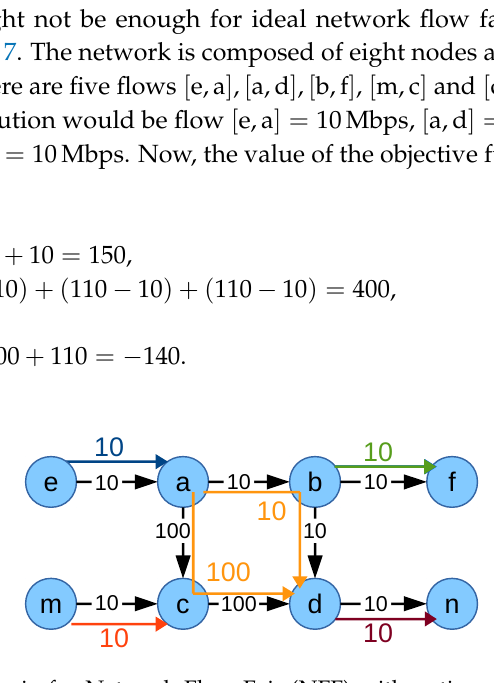
Figure 7. Example scenario for Network Flow Fair (NFF) with optimum allocation. Blue circles: nodes; black arrows/numbers: links with capacities; colored arrows/numbers: flows with capacity assignments. All numerical values in